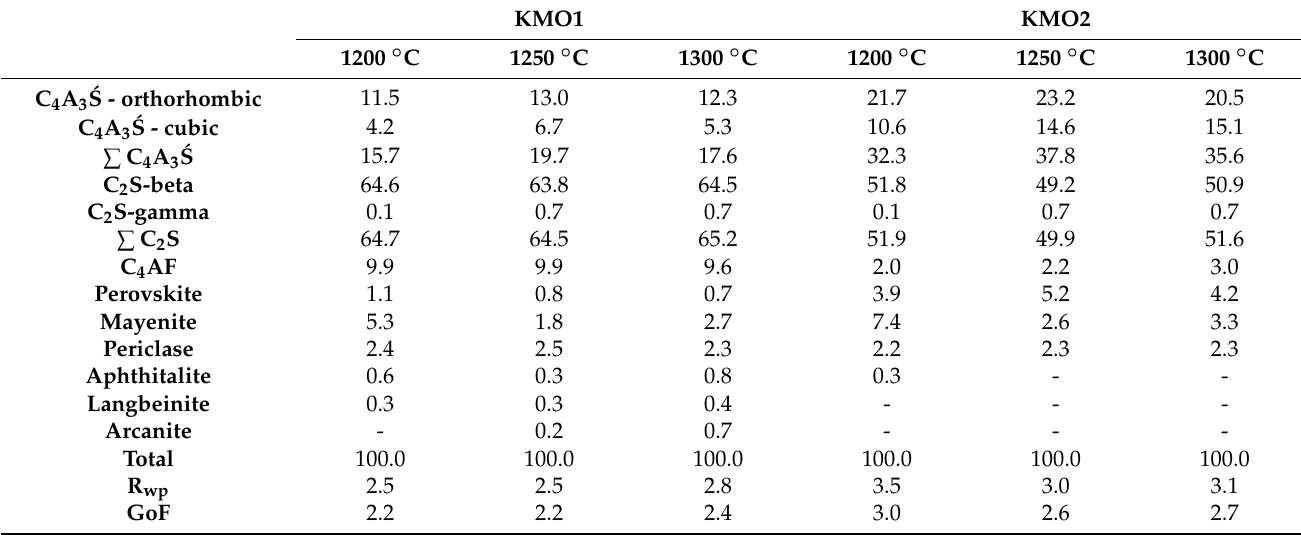
Table 5. Phase composition of cement clinkers KMO1 and KMO2, sintered at different temperatures, as determined by Rietveld refinement (wt. %). R wp presents the weighted profile R-factor and GoF represents the goodness of